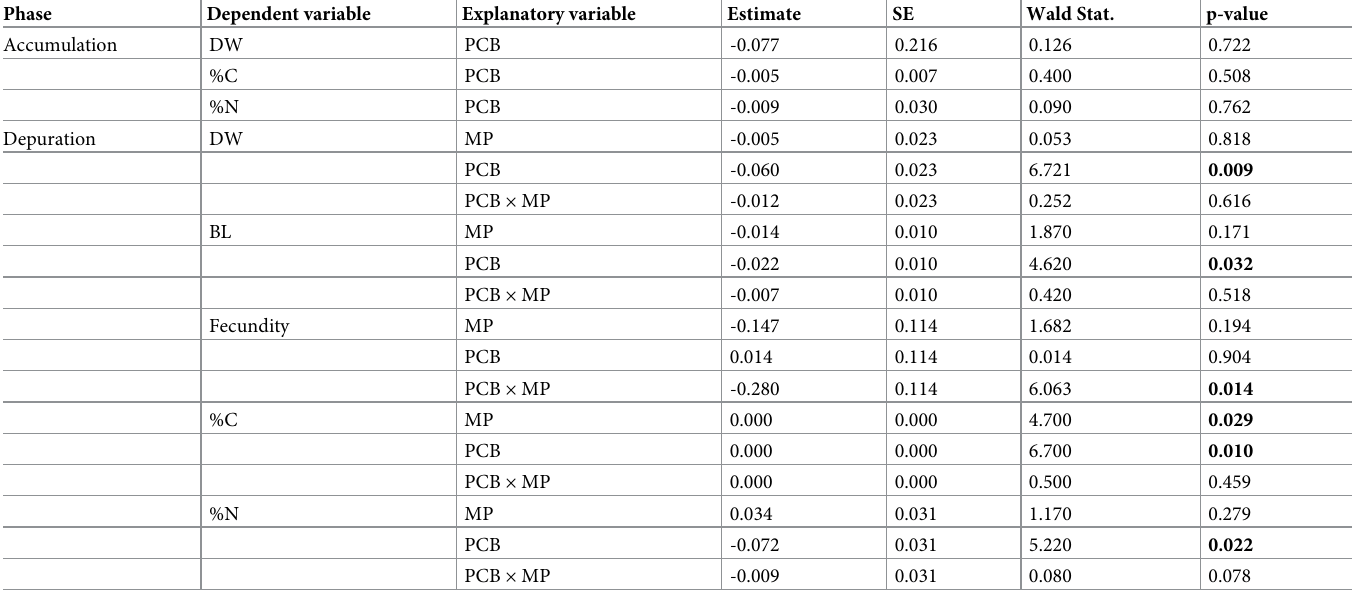
Table 2. Summary of generalized linear models